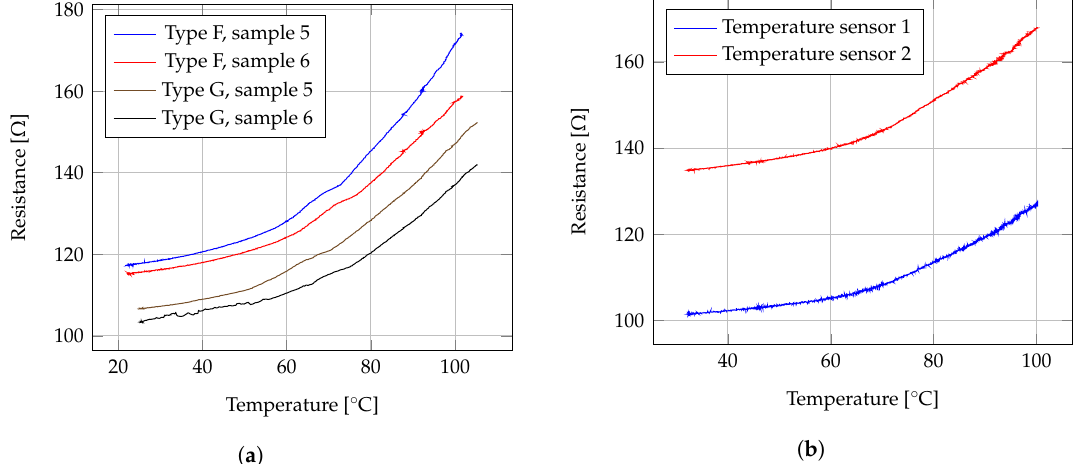
Figure 6. ( a ) Resistance vs. temperature profile from measured data at two test carbon printed resistors. ( b ) Measured data from samples of temperature sensors 1 and 2. Table 1. Statistics from characterization of carbon resistors represented in Figure 2. Resistance at Room temp.